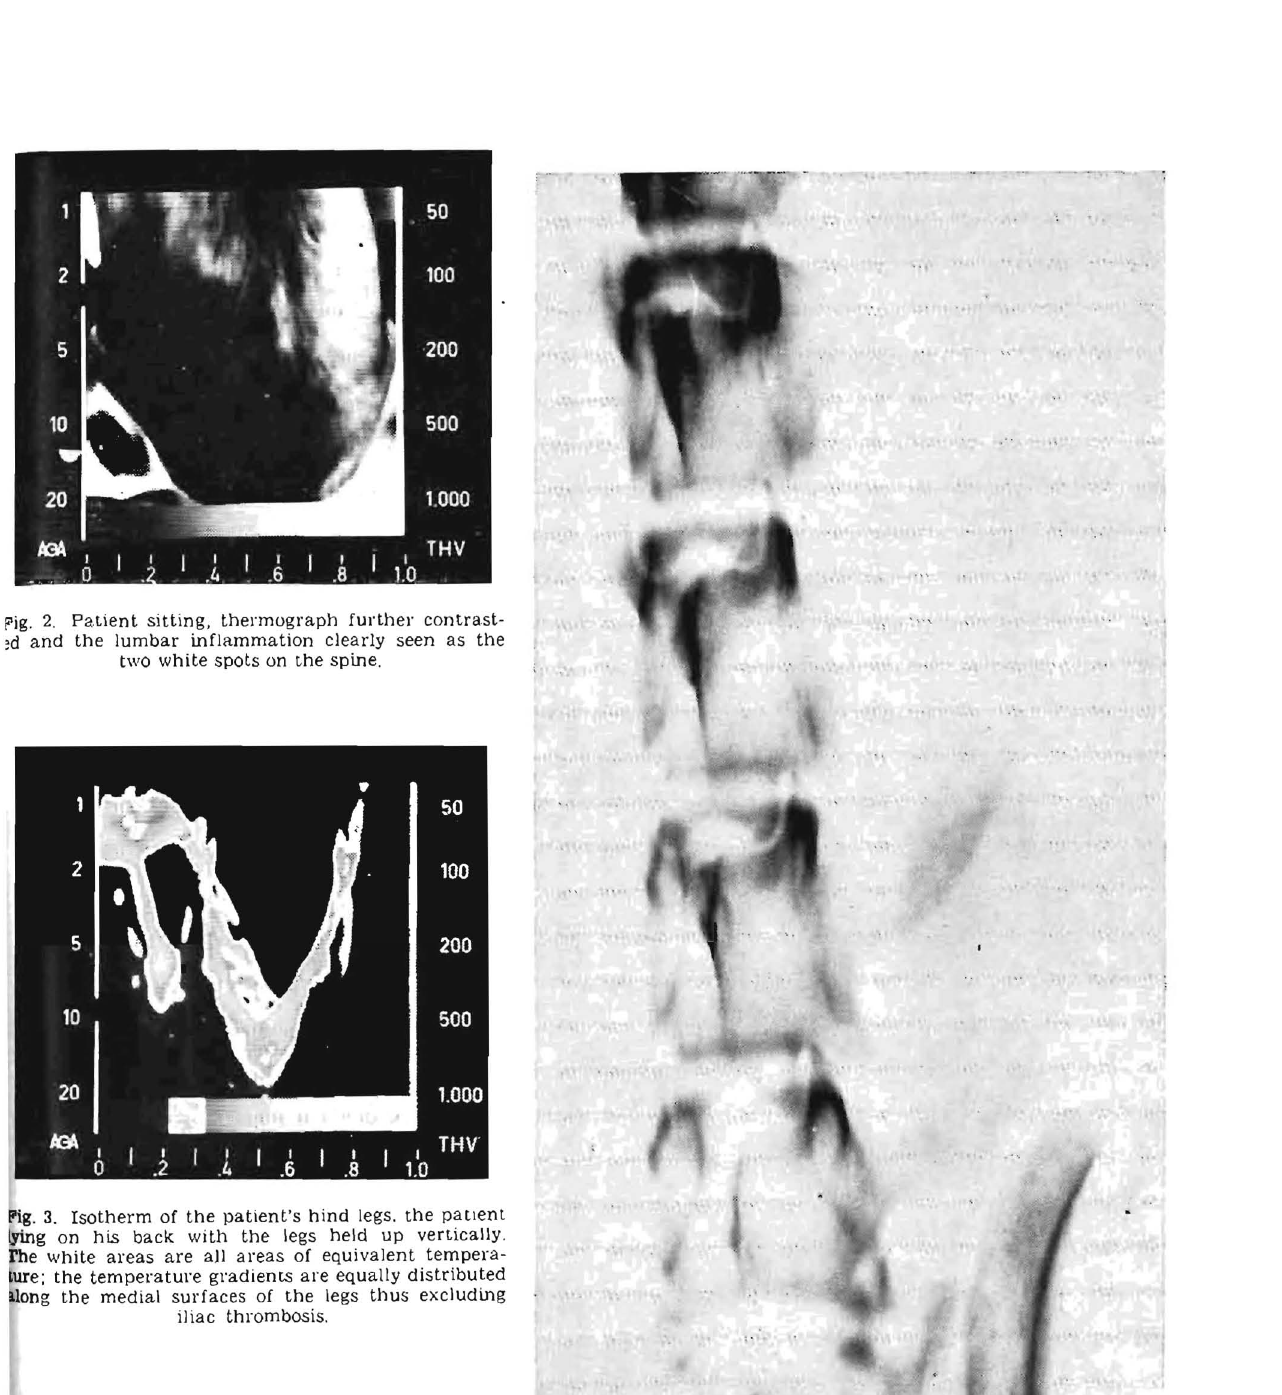
two white spots on the